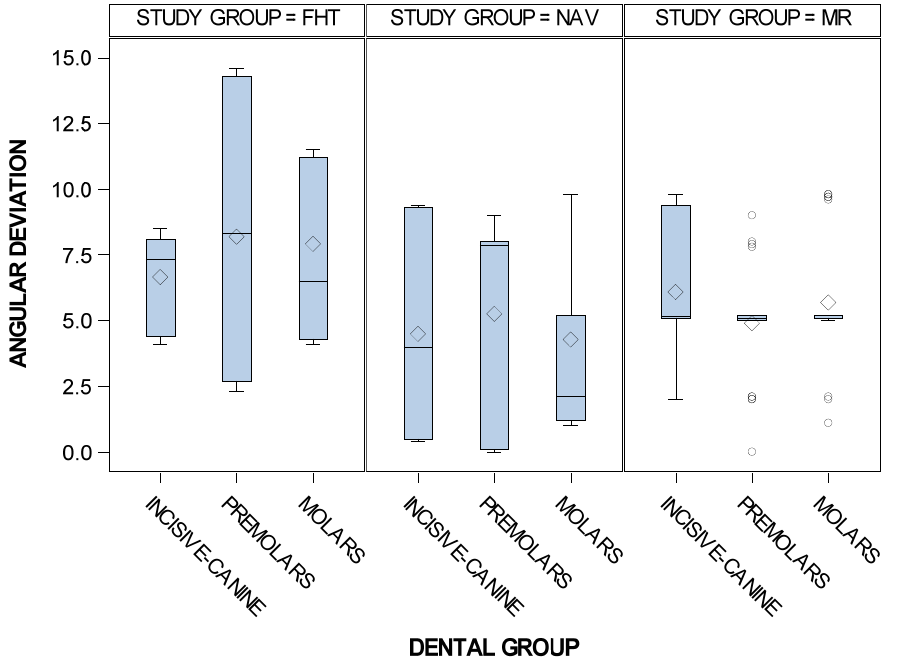
Figure 12. Box plot of the angular deviations of the orthodontic micro-screws placed using the computer-aided static navigation technique, mixed reality technique and conventional freehand technique in the incisive-canine, premolar and molar dental sectors.